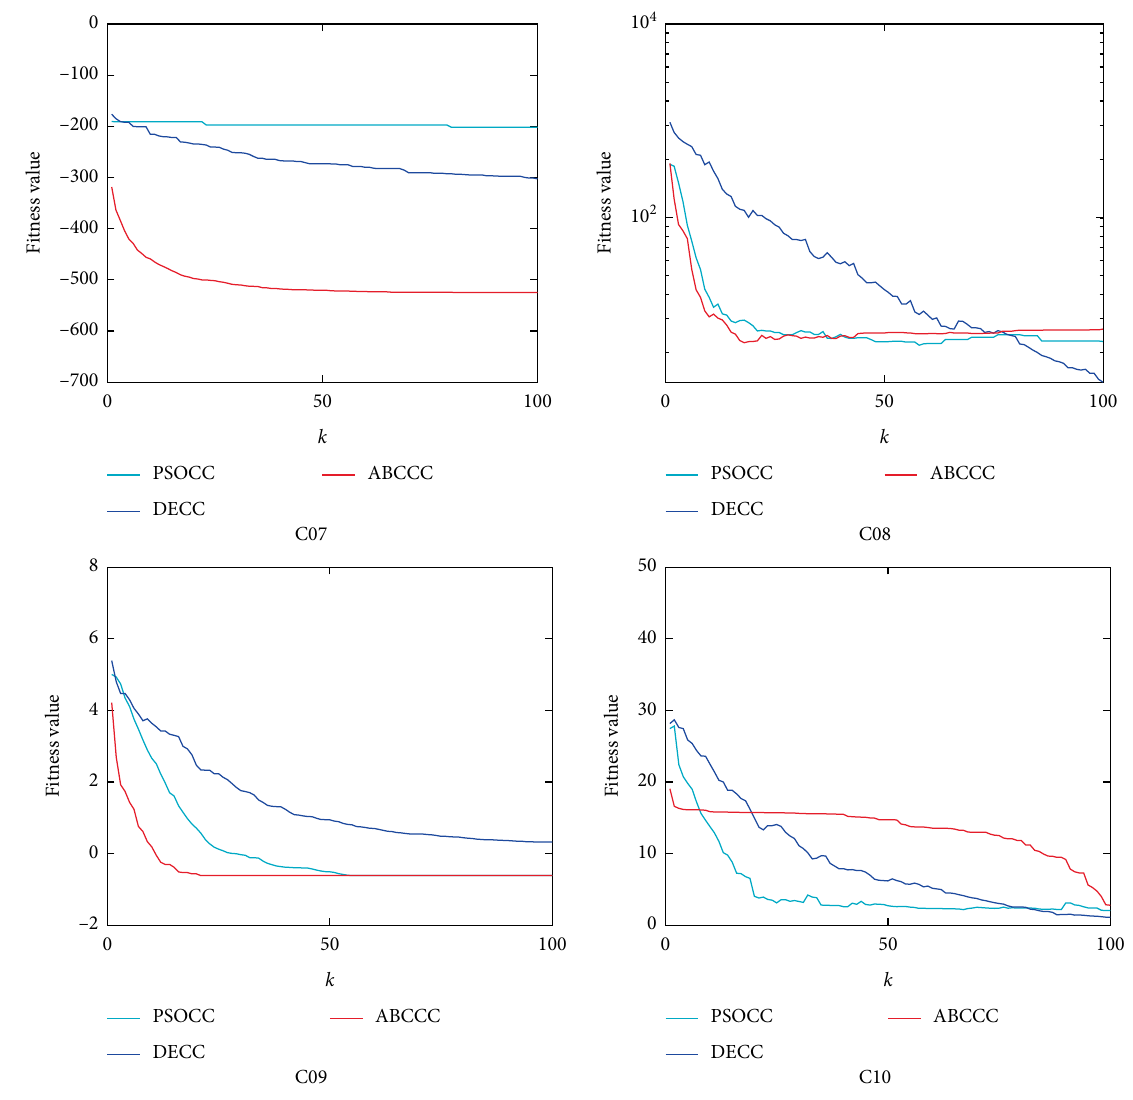
Figure 2: Average convergence of the algorithms (10-